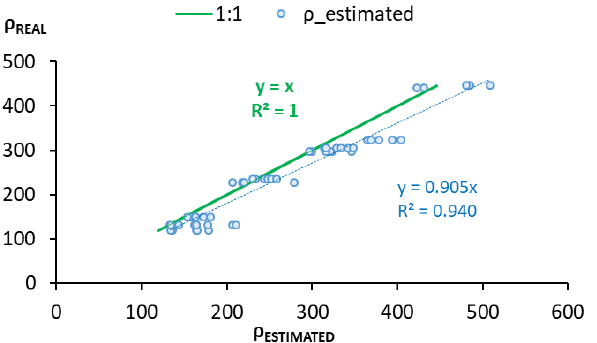
Figure 10. Graphic representation of the real vs. estimated data. Real data 1:1 line: green line. ρ = f(Rs): blue dots.